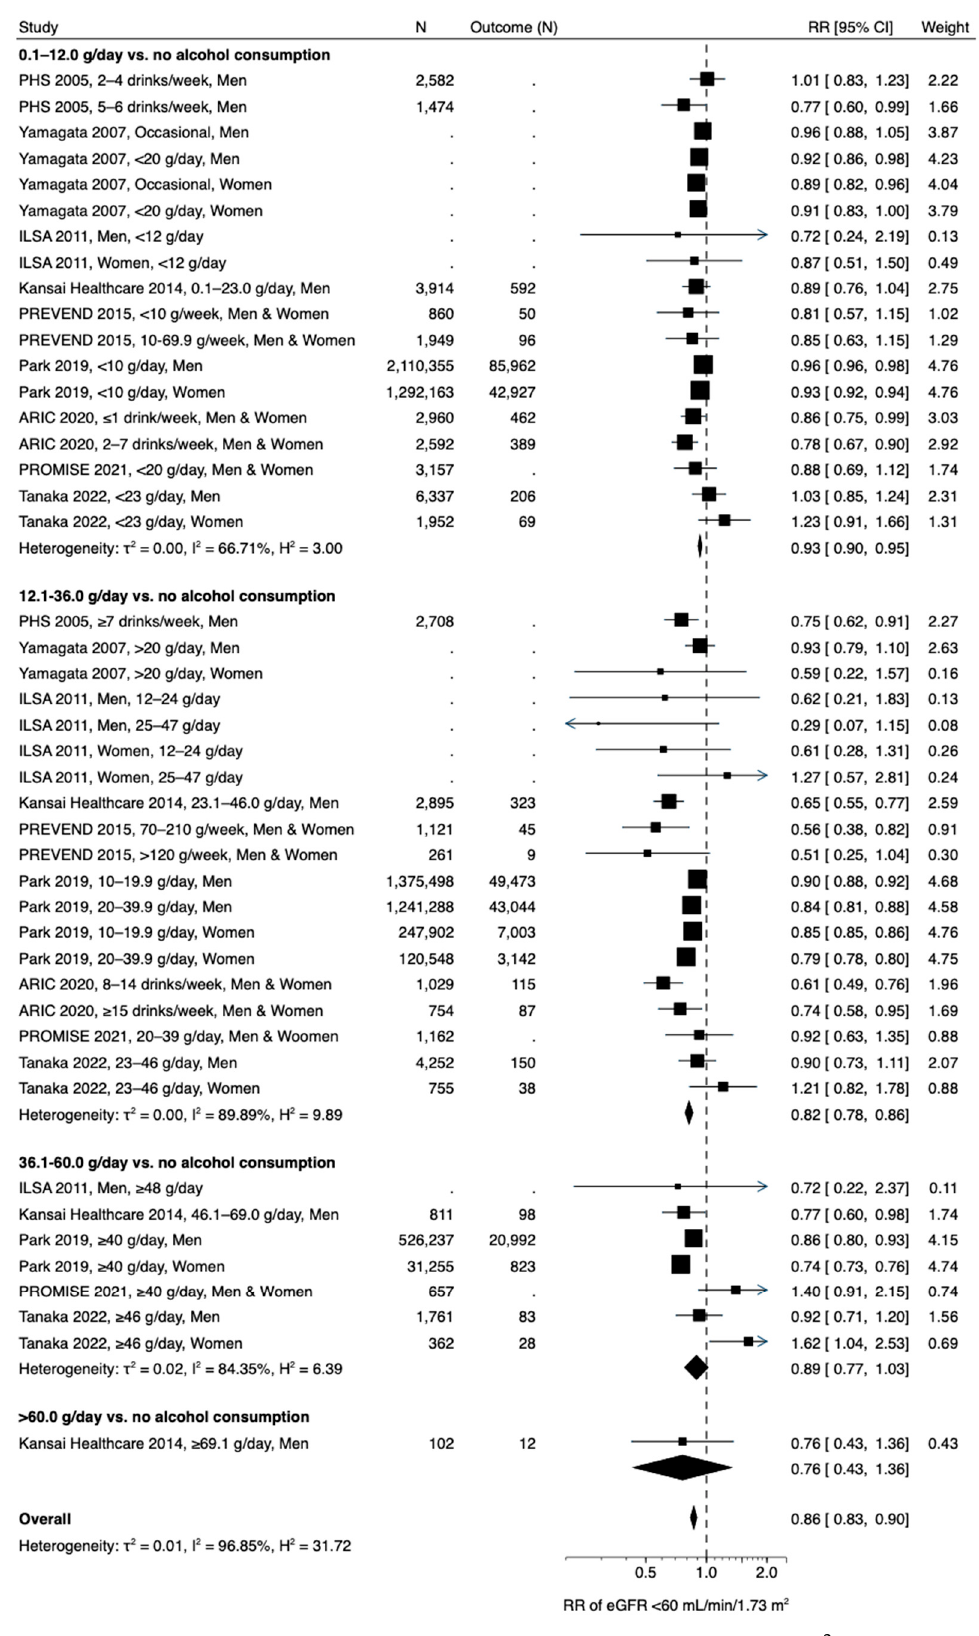
Figure 3. Alcohol consumption and incidence of low eGFR <60 mL/min/1.73 m 2 . CI, confidence in- terval; eGFR, estimated glomerular filtration rate; RR, relative risk [19,21,32–34,36,37,39,40].